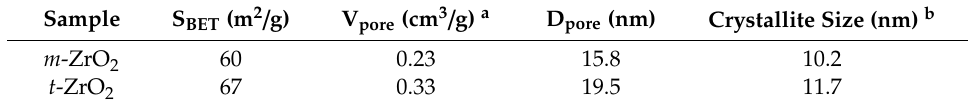
Figure 1. XRD patterns ( a ) and HRTEM images ( b,c ) of the ZrO 2 samples. Table 1. Physical and morphological properties of ZrO 2